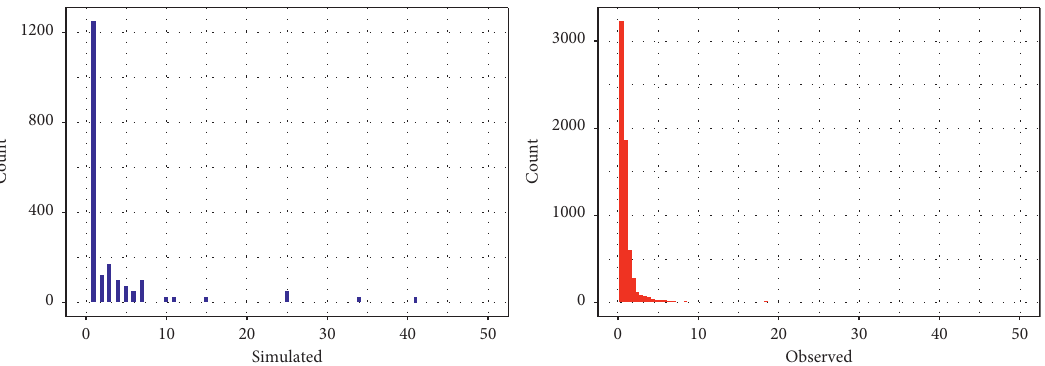
Figure 5: Durations for simulated and observed incidents.